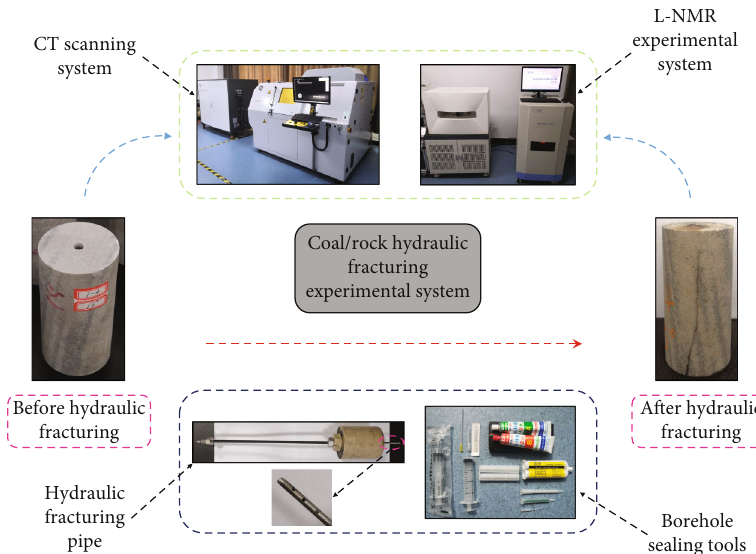
Figure 5: Schematic diagram of equipment and experimental